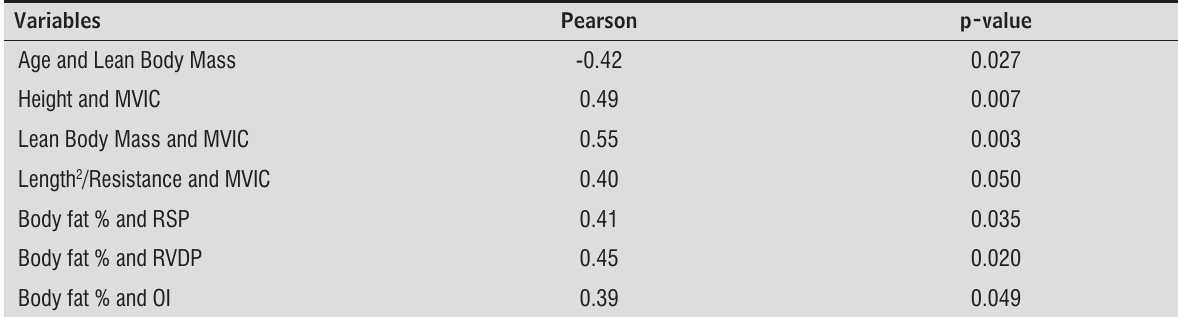
Table 3 - Significant associations found in the study